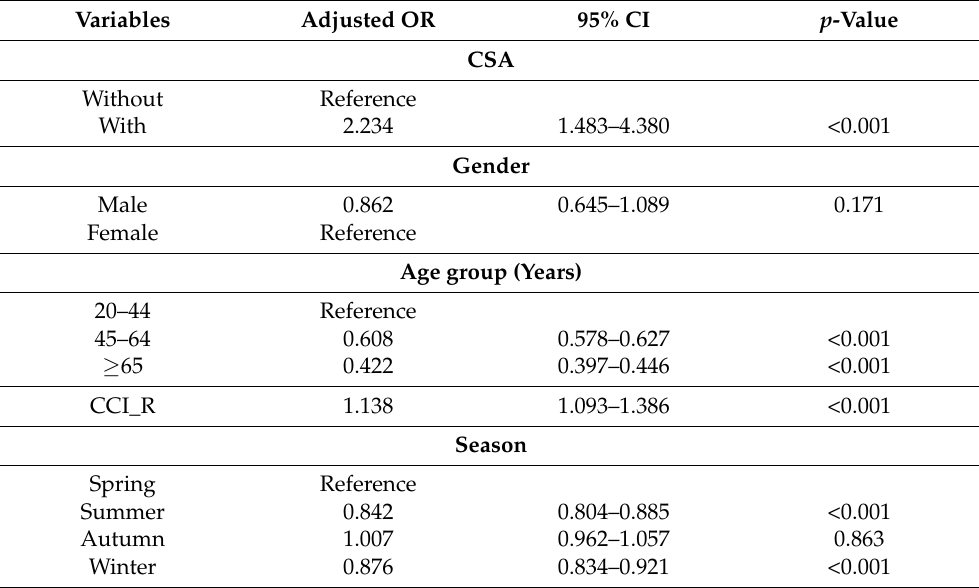
Table 2. Logistic regression of obesity variables.